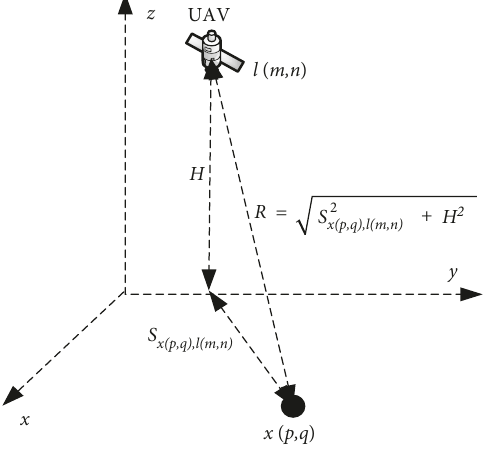
Figure 3: Coordinates of the